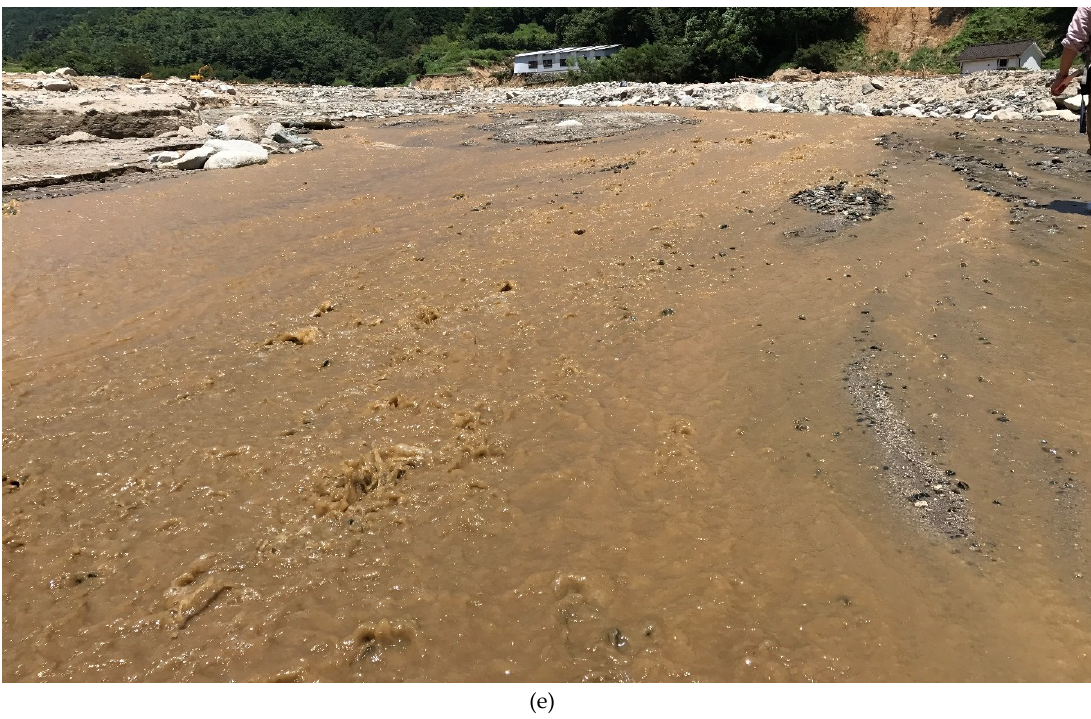
Figure 2. These are photographing about sediment or river environment after the disaster (2 August 2017). ( a ) Photo of a left bank section exposed by erosion near the Masue Elementary School; ( b ) photo of erosion of the right bank in the downstream area; ( c ) photo of a sand layer, including gravel, exposed by erosion; ( d ) photo of flood sediments comprising a sand and pebble layer; ( e ) photo showing black gravel rolling on the riverbed due to water-flow.